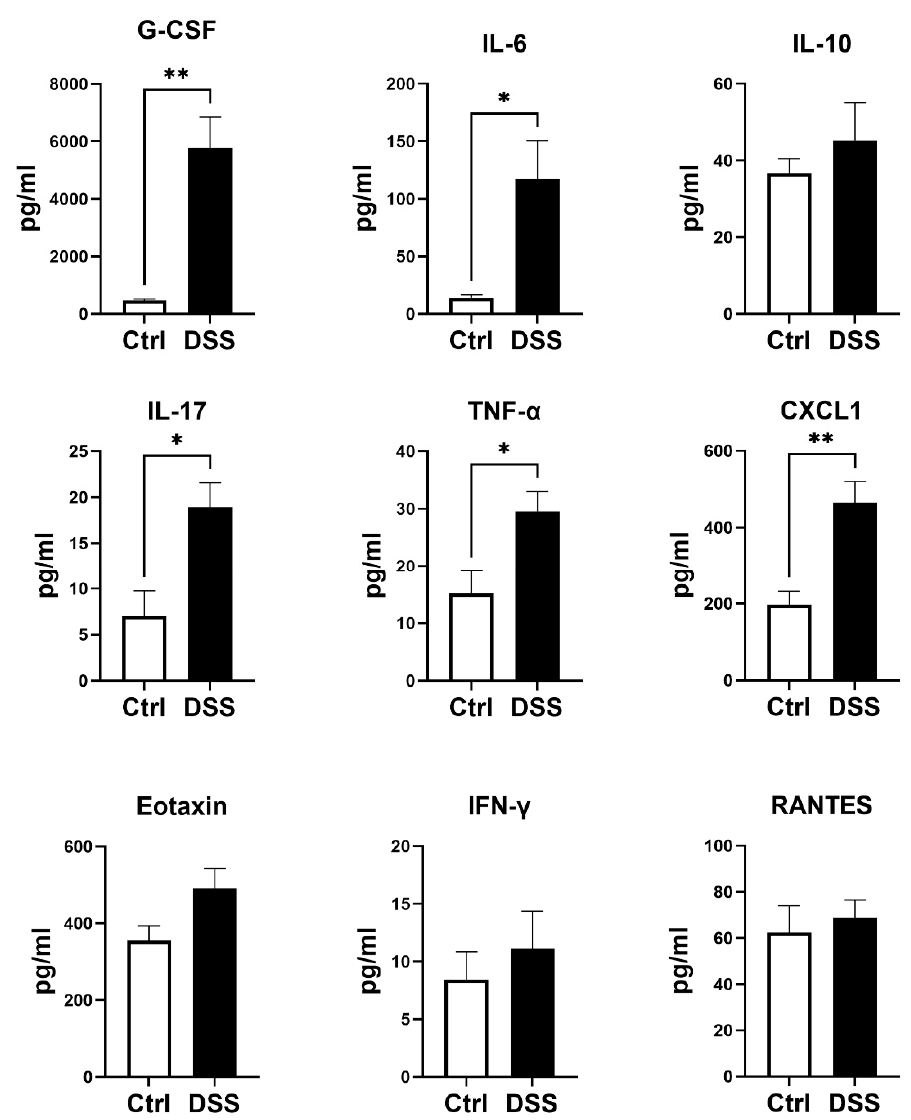
Figure 2. Levels of plasma cytokines in colitis model. Results are expressed as mean ± SEM. * p < 0.05, ** p < 0.01, by unpaired 2-tailed Student’s t -test, n = 5 mice in each group. G-CSF, granulocyte colony- stimulating factor; TNF- α , tumor necrosis factor alpha; IFN- γ , interferon gamma; IL, interleukin; CXCL1, chemokine ligand 1; RANTES, regulated upon activation, normal T cell expressed and presumably